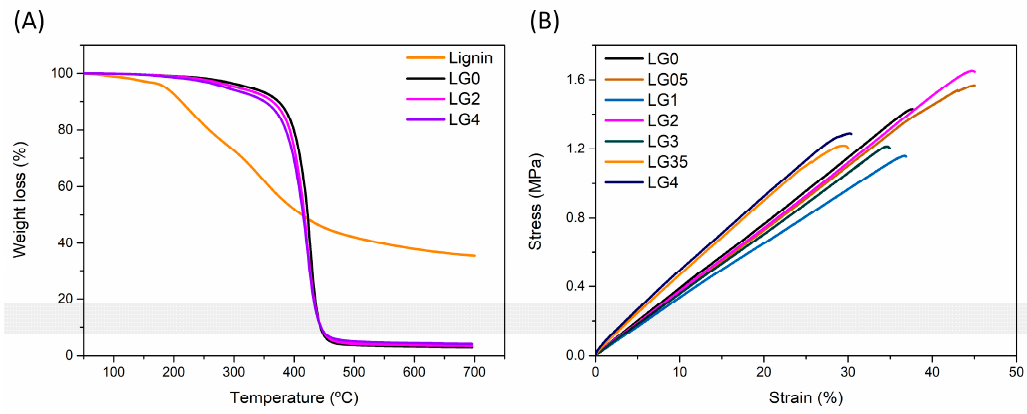
Figure 5. ( A ) TGA curves of Lignin and printed composites LG0, LG2, and ( B ) Stress-strain behavior of pure acrylate resin and lignin printed composites (representative curves).